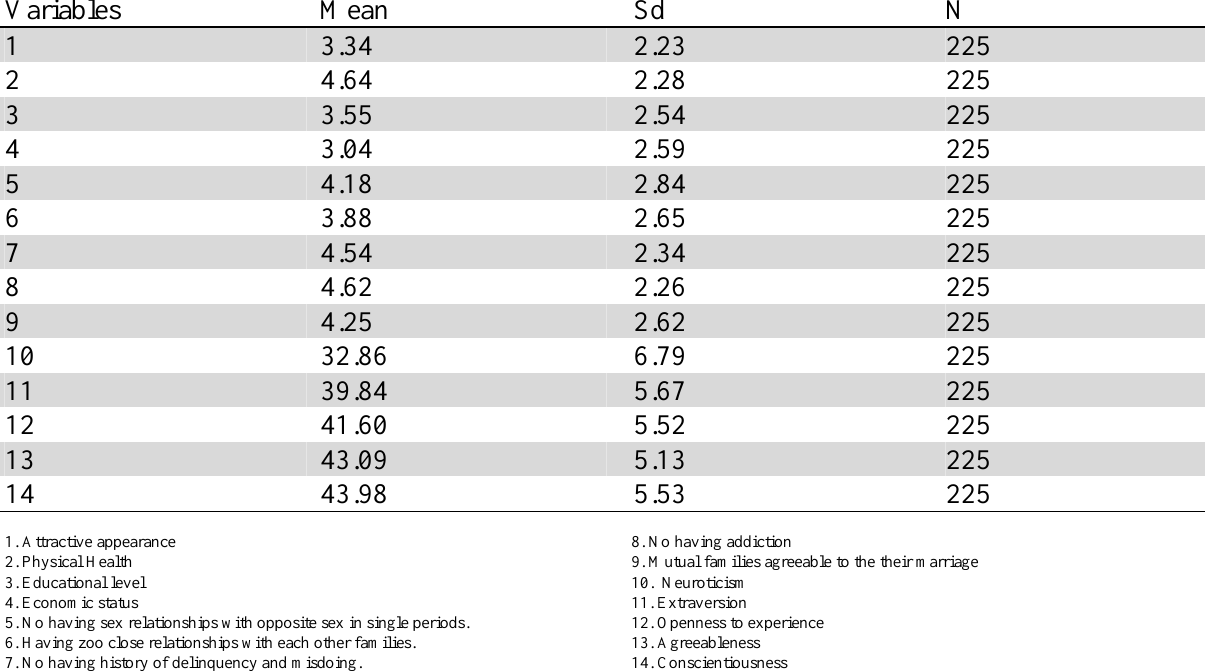
Pearson correlations among dependent and independent variables Variables Openness to experience